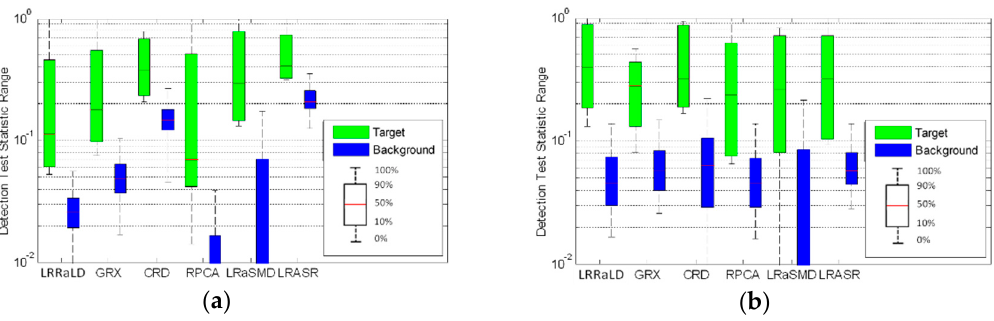
Figure 18. Statistical separability analysis of the AD algorithms: ( a ) Hyperion data set; and ( b ) HYDICE data set. Table 4. AUC and execution time of different methods.